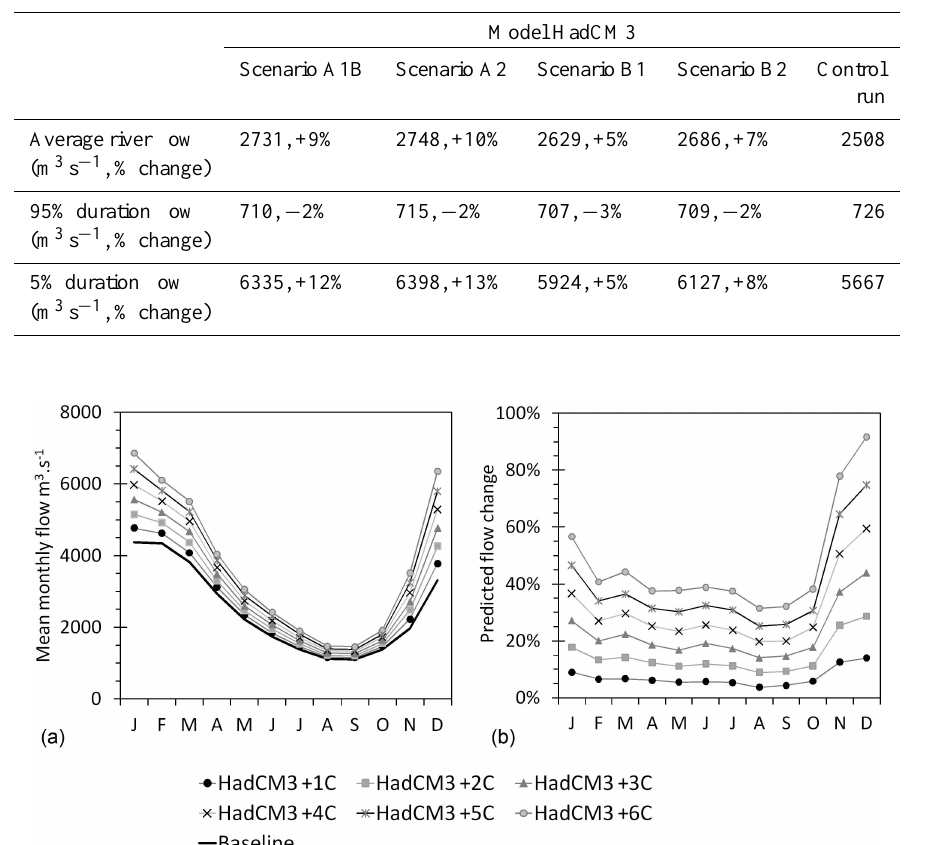
Table 3. Hydrological modelling results using the same GCM (HadCM3) and different greenhouse emission scenarios. Control run was calculated using 95 years, from 2006 to 2100.